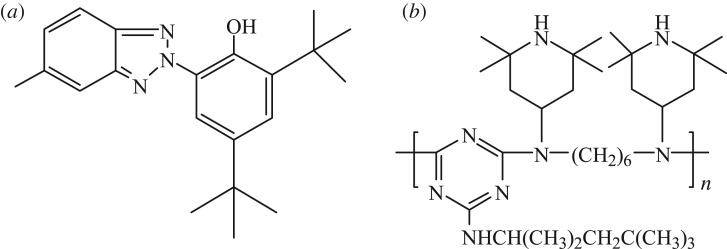
Chemical structure of the UV stabilizers used in this study. (a) UV-327 [C20H24ClN3O] and (b) HS-944 [(C35H66N8)n = 4–5].